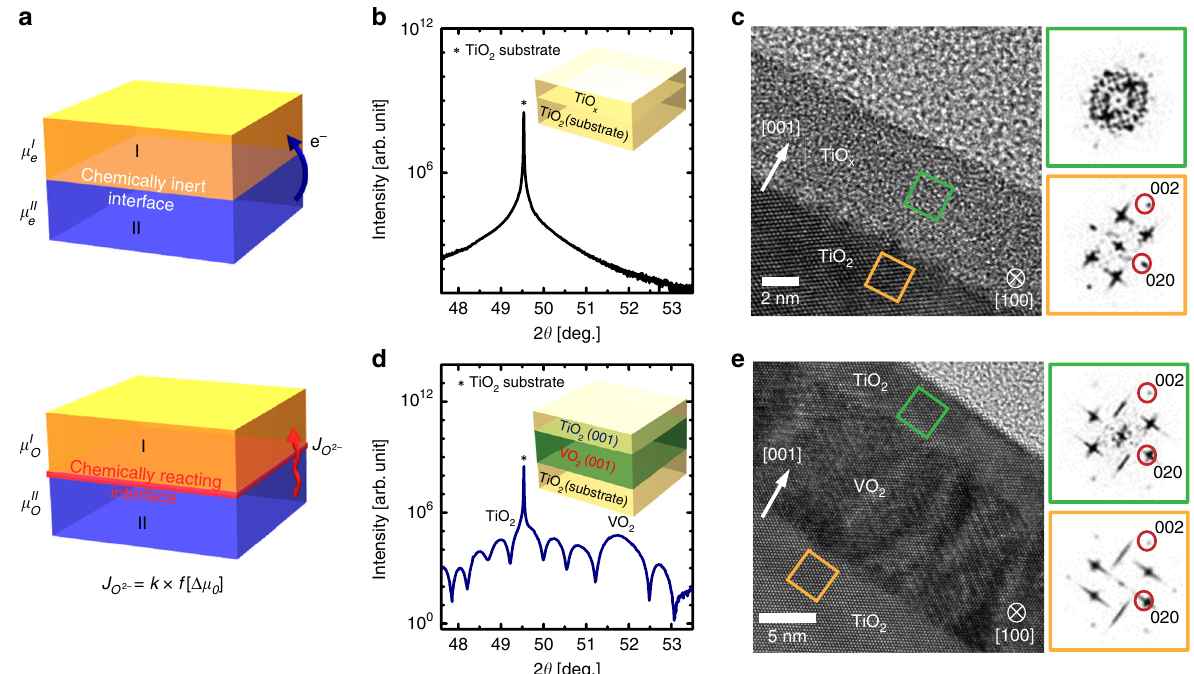
Fig. 1 Low-temperature epitaxy of rutile TiO 2 on VO 2 sacri fi cial templates. a Schematics of possible directional charge (top) and ionic (bottom) transport due to chemical potential mismatch ( Δ μ ) across the interface with loss of translational symmetry. Symmetrical x-ray scan of b TiO X /TiO 2 homostructure and d TiO 2 /VO 2 /TiO 2 heterostructure containing TiO 2 fi lms grown at 150 °C. Contrary to the absence of peak around TiO 2 substrate peak in homostructure ( b ), (002) Bragg re fl ections and Kiessig fringes around the peak from TiO 2 substrate in heterostructure in d indicate that the TiO 2 fi lms are epitaxially grown at 150 °C on VO 2 templates with sharp interface. HRTEM images and FFT patterns of c TiO X /TiO 2 homostructure (scale bar = 2 nm) and e . TiO 2 /VO 2 /TiO 2 heterostructure (scale bar = 5 nm) projected with [100] zone axis. Unlike the amorphous nature of TiO X fi lms in homostructures (green square in c ), obvious diffraction spots were observed in the FFT pattern of the TiO 2 fi lms on VO 2 /TiO 2 (green square in e ), and were same as those observed from the TiO 2 substrates (yellow square in e ); this similarity indicates an identical epitaxial relationship of TiO 2 epitaxial fi lms with TiO 2 substrates in TiO 2 /VO 2 /TiO 2